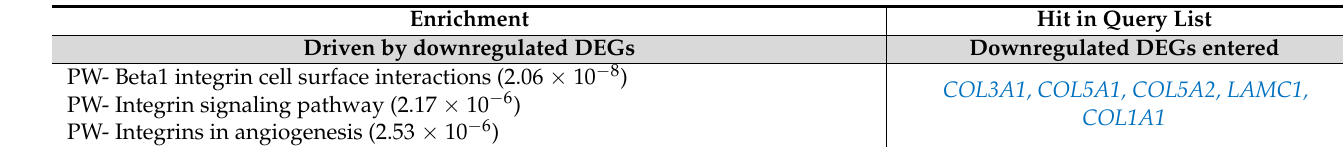
Table 1. Functional enrichment driven by down- and upregulated DEGs in AA-NL fibroblasts. Based on the results of the comparison AA-NL vs. EA-NL, all 33 downregulated DEGs (in blue) were entered in ToppFun to determine pathways (PW) and gene ontology terms, such as biological process (BP) and molecular function (MF). The same was performed for all 36 upregulated DEGs (in red). The p -values are shown in